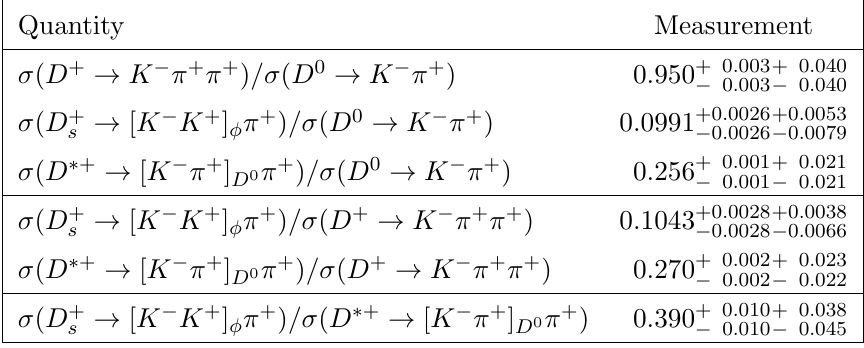
f ) is shorthand for (cid:27) ( D ) ( D f ). ! (cid:2) B !